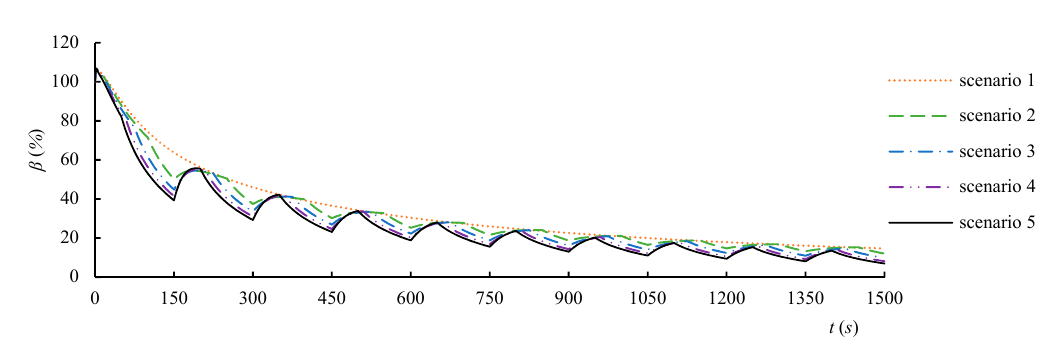
Figure 17. Curves of ESR ( β ) change with time for different scenarios.